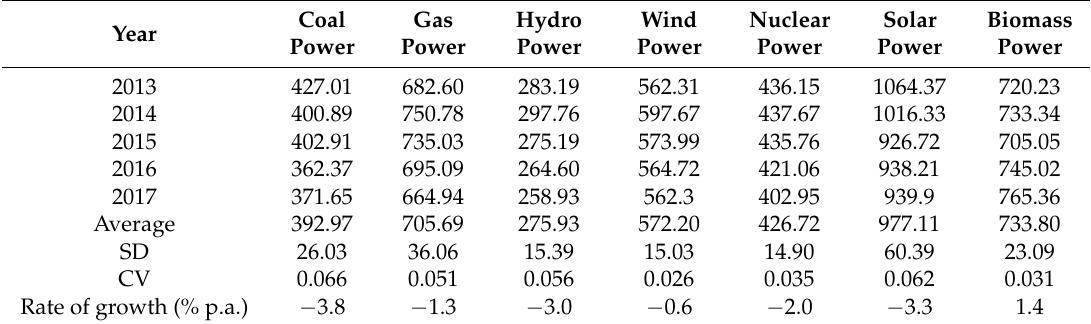
Table 1. Feed-in electricity prices in China (national averages), 2013–2017 (in